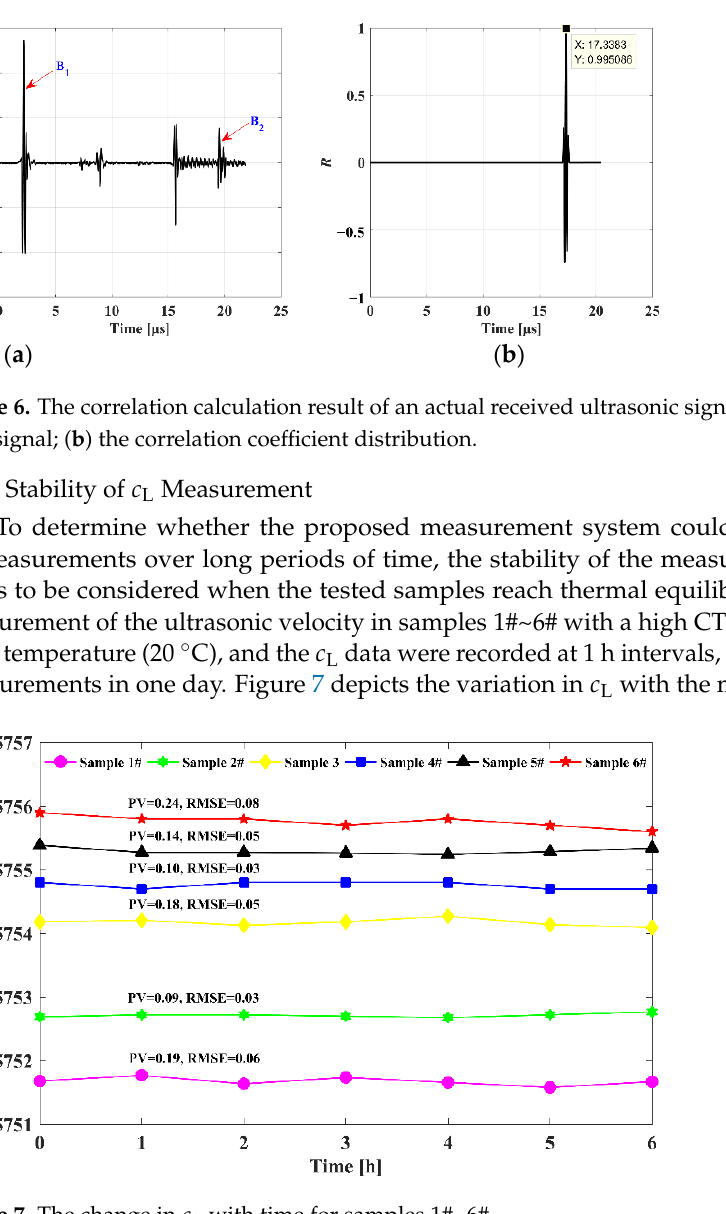
Figure 7. The change in 𝑐 (cid:2896) with time for samples